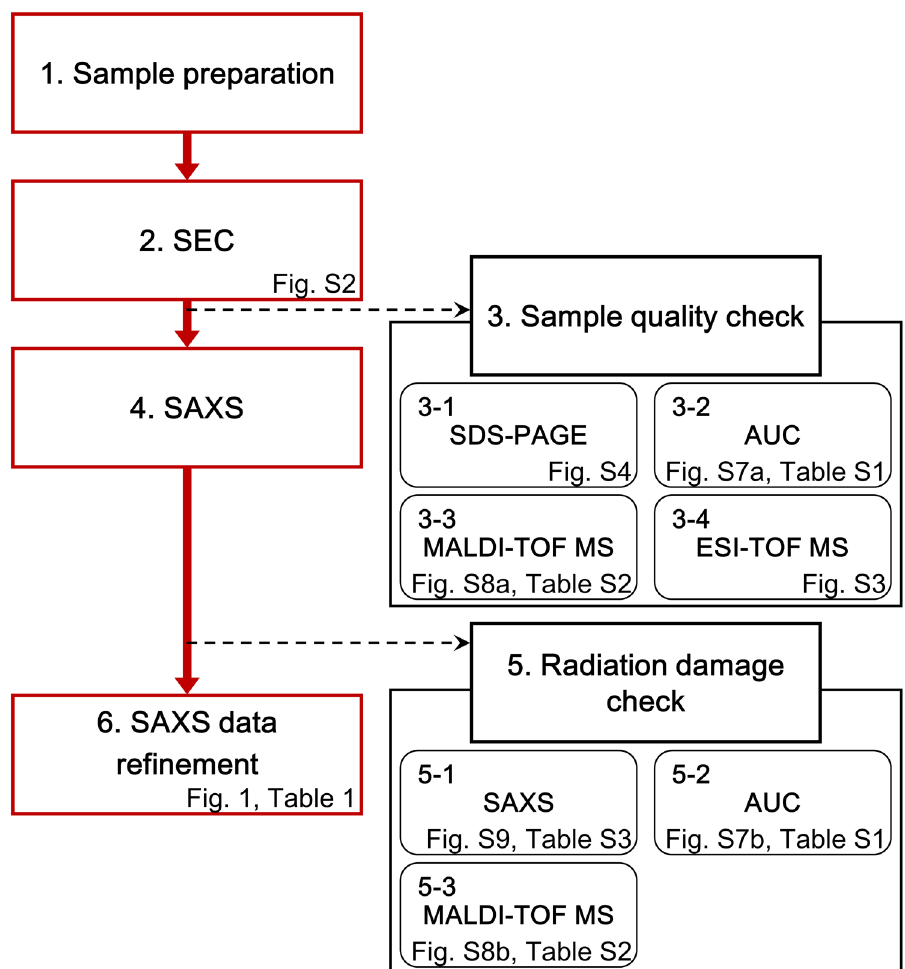
Figure 8. Flowchart of the work steps for aggregation-free SAXS measurement of ER-60. To obtain aggregation-free SAXS data, several methods were assembled. The procedure consists of sample preparation, purification with SEC, quality checks, SAXS measurement, radiation damage check, and data